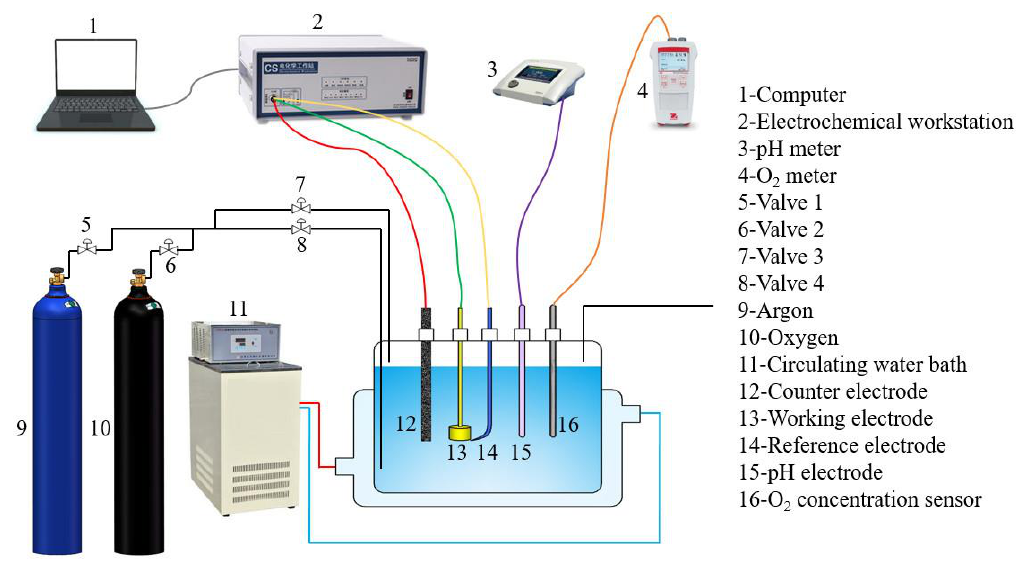
Figure 1. Schematic diagram of experimental setup.